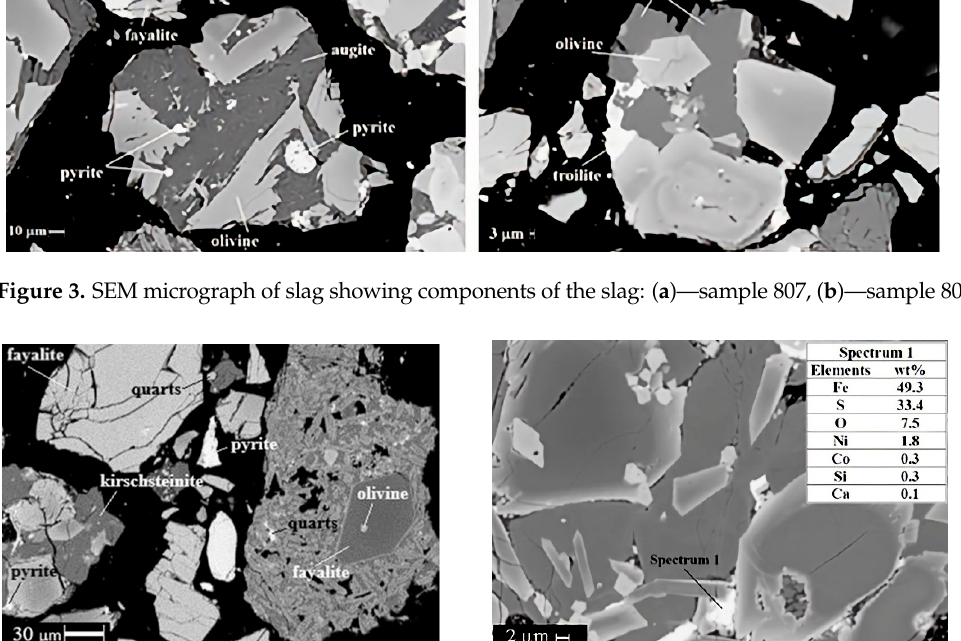
Figure 3. SEM micrograph of slag showing components of the slag: ( a )—sample 807, ( b )—sample 809.